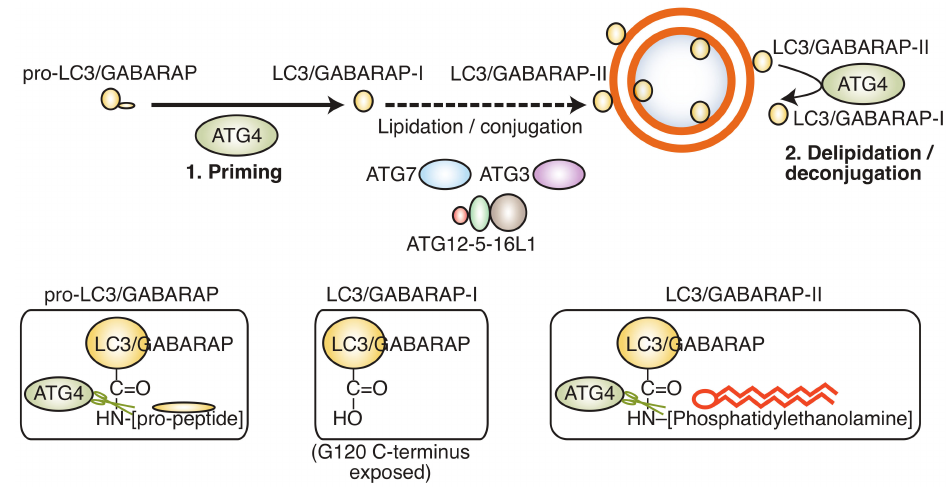
Figure 2. LC3 / GABARAP protein processing. The LC3 / GABARAP pro-peptide pro-LC3 / GABARAP is first cleaved at the C-terminus by ATG4B, generating LC3 / GABARAP-I in the cytoplasm. LC3 / GABARAP-I is then conjugated to phosphatidylehtanolamine (PE) by ATG7 / ATG3 and the ATG12-5–16L1 complex. LC3 / GABARAP-PE can be deconjugated by ATG4 proteins for recycling. The different C-terminal ends of pro-LC3 / GABARAP, LC3 / GABARAP-I, and LC3 / GABARAP-II are depicted in the bottom